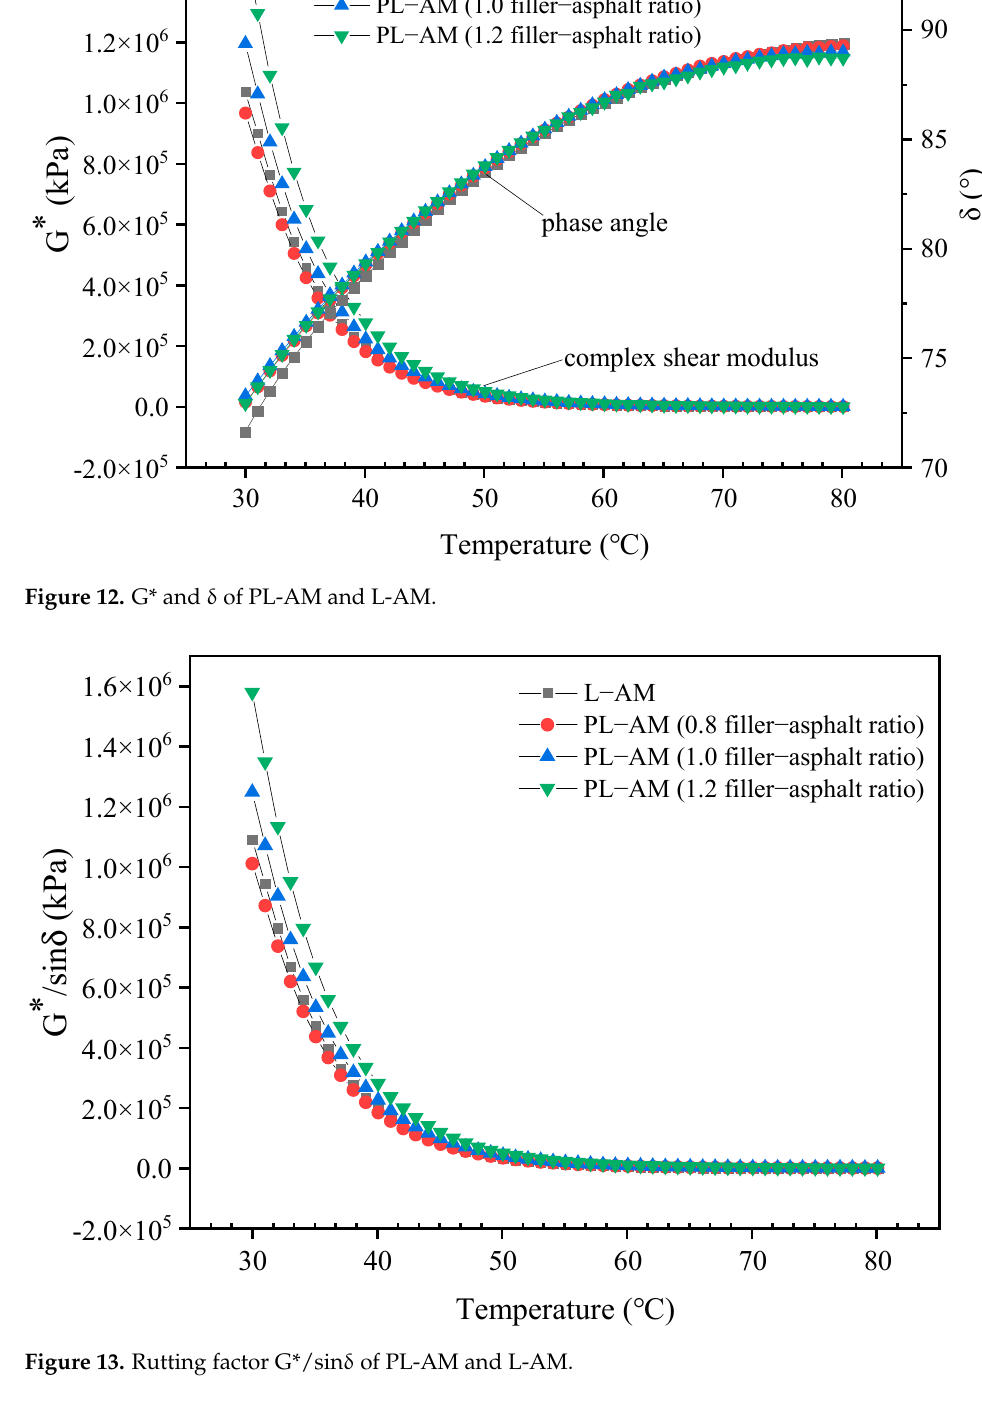
Figure 13. Rutting factor G*/sin δ of PL-AM and L-AM.